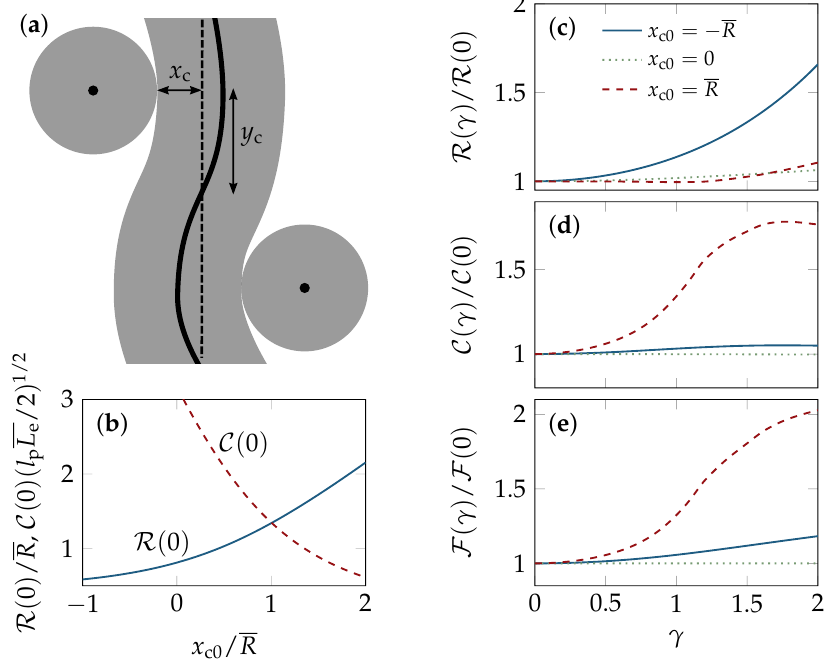
Figure 6. Unit-cell model by Fernández et al. [21]. ( a ) The test tube is deformed by two confining tubes ( γ = 0 ) (Sketch adapted from Reference [21]); ( b ) The zero-strain values of the average tube radius R ( γ = 0 ) varies with the unit-cell conformation, which is characterized by and the mean curvature C the deflection x c0 . Shearing of the network is mimicked by an affine displacement of the contact points with (or centers of) the confining tubes. There is a trade-off between bending and confinement, since a more strongly bent conformation allows for a wider tube, which, on average, gives rise to a ( γ ) and ( d ) the strain-induced tube dilation and bending, quantified by ( c ) the average tube radius R ( γ ) with strain γ ; ( e ) The total free energy ( γ ) increases upon shearing as required mean curvature C F by mechanical stability. All curves were computed numerically from the full non-linear